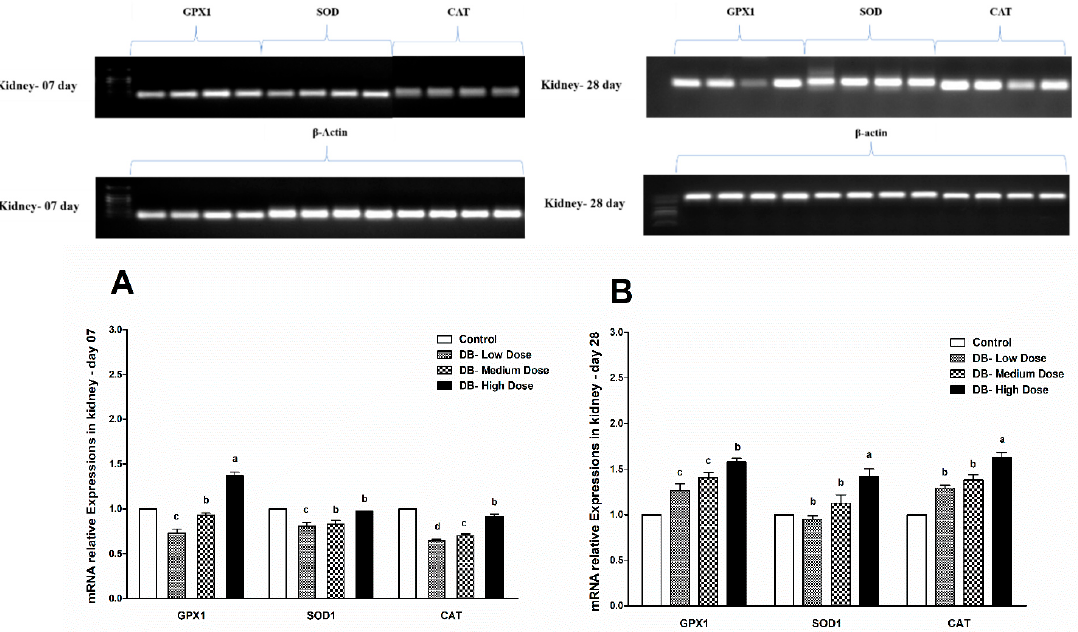
Figure 12. Effects of DB supplementation on kidney mRNA expressions of antioxidant- related genes at 07 days ( A ) and 28 days ( B ) of age. Data are presented as mean value ± SEM (n = 6). Values without the same mark (a–d) represent statistically significant differences ( p < 0.05). GPX1, glutathione